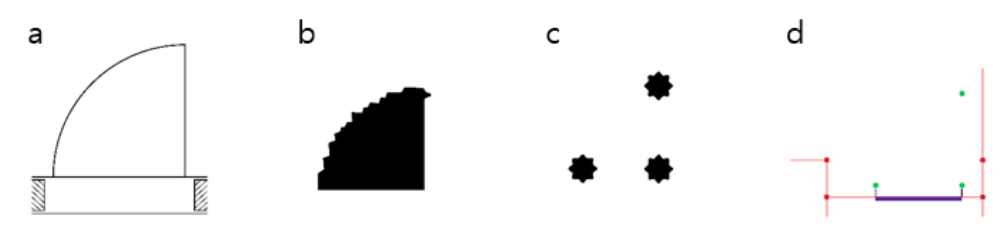
Figure 6. Process of door extraction: ( a ) raw image; ( b ) rasterized door, ( c ) extracted points; ( d ) final output.